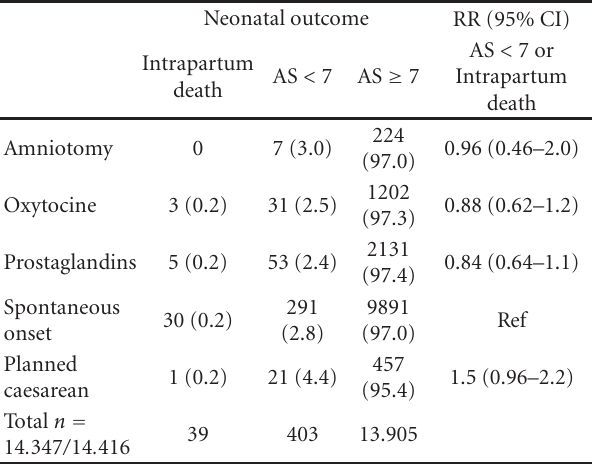
Table 2: Neonatal condition after birth in pregnancies complicated by